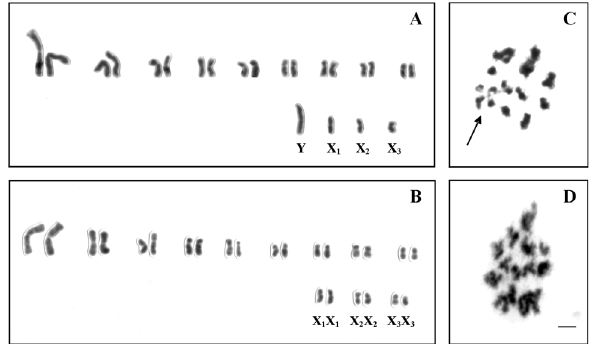
Figure 2 - Mitotic and meiotic chromosomes of Cicindela aurulenta . (A) Male karyogram, 2n = 18 + X 1 X 2 X 3 Y; (B) Female karyogram, 2n = 18 + X 1 X 1 X 2 X 2 X 3 X 3 ; (C) male metaphase I and (D) male metaphase II, n = 9 + X 1 X 2 X 3 . Arrow indicates the multiple sex chromosomes. Bar = 4 µ m.